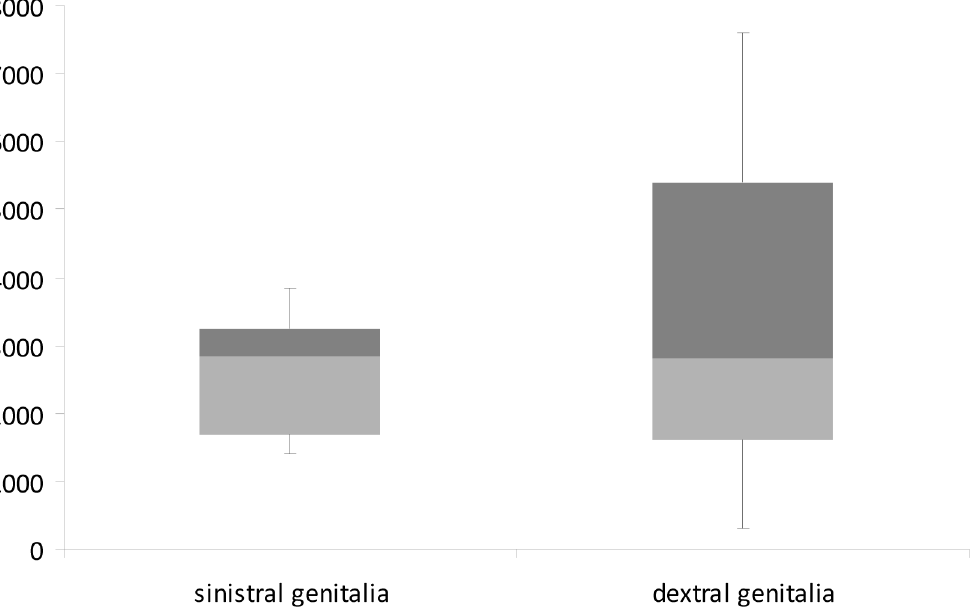
Fig 2. Post-copulatory spermatophore attachment duration (seconds) of C . baldersoni males with sinistral and dextral genitalia when mated with virgin females. Boxplots show medians and first and third inter-quartile ranges. Whiskers are extended to maximum and minimum values.